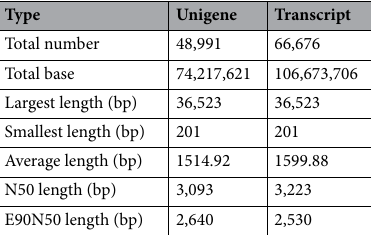
Table 2. The quality and length statistics of the transcripts and unigenes.